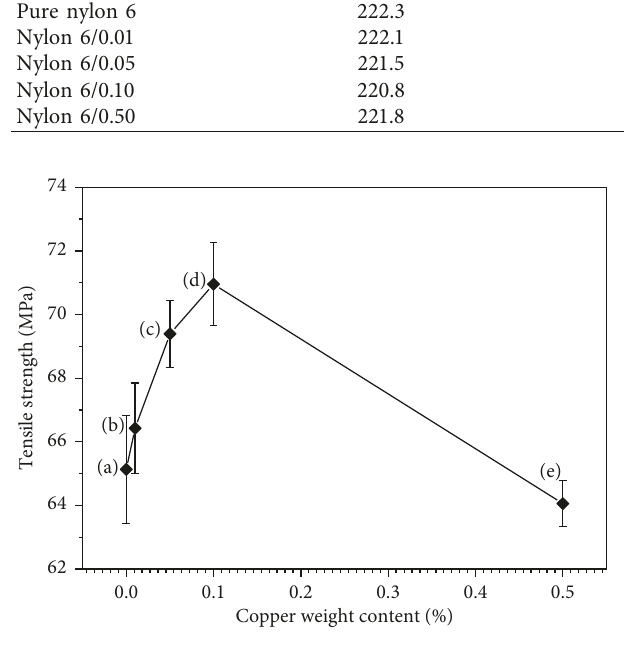
Figure 6: Tensile strength: (a) nylon 6 and nanocomposites with (b) 0.01, (c) 0.05, (d) 0.10, and (e) 0.50 wt.% of copper nanoparticles.